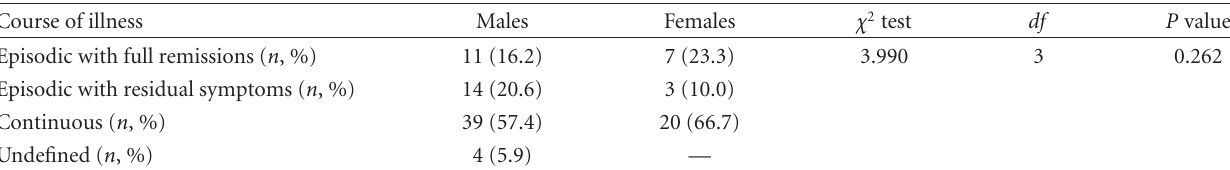
Table 3: Course of illness according to gender.